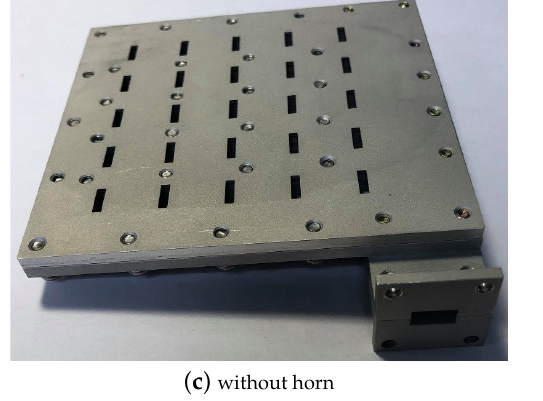
Figure 12. Photographs of the manufactured prototype.